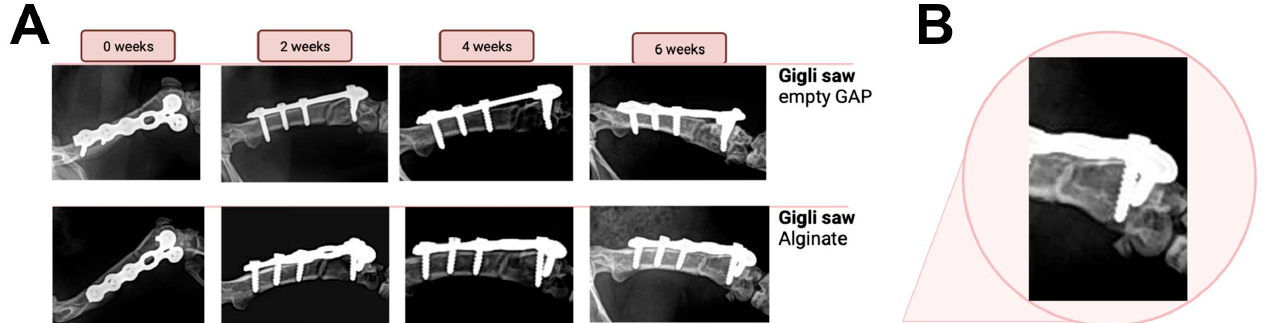
Figure 5. ( A ) Fracture consolidation over a time period of 6 weeks post-surgery after performing a complete osteotomy using a Gigli saw. The top row shows samples without the implantation of an alginate clot, whereas the bottom samples were treated with alginate. ( B ) The fracture gap showed full bridging 6 weeks post-surgery for all animals investigated (representative image of the alginate-treated group).